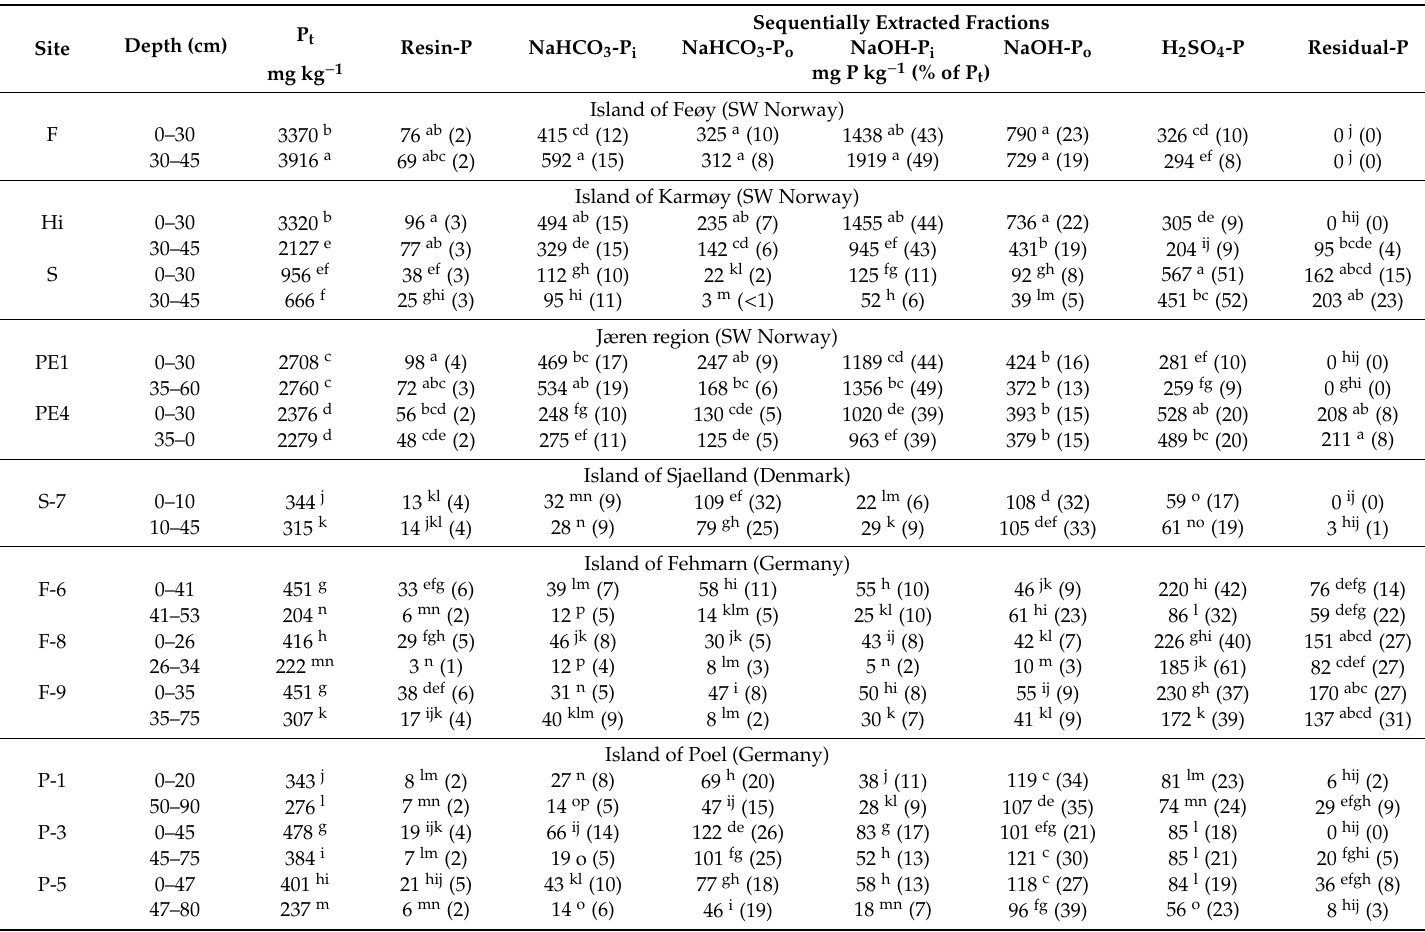
Table 2. Mean P concentrations (mg kg − 1 ) in di ff erent extracts of the sequential P fractionation. P t is the sum of sequentially extracted fractions, sometimes slightly di ff erent from P t -values in Table 1. Values within P t and the same P-species with the same letter are considered not significantly di ff